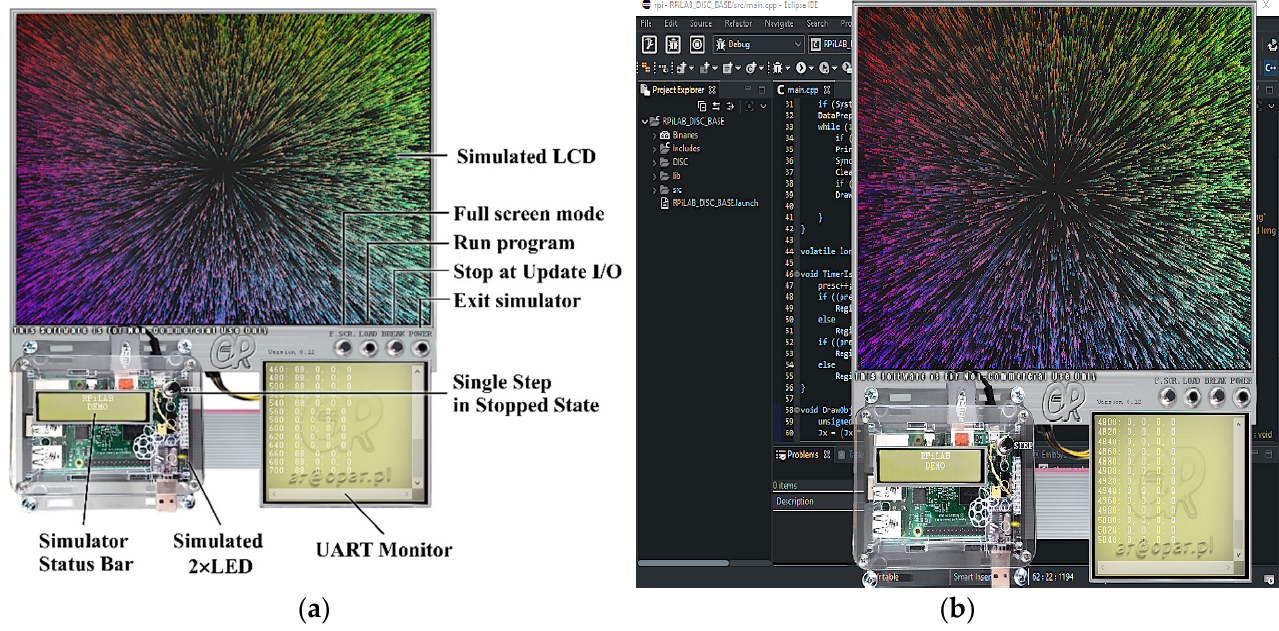
Figure 14. Virtual simulator of the RPILAB didactical module running demo program: ( a ) simulator components and GUI; ( b ) simulator running on Microsoft Windows platform under Eclipse IDE control.